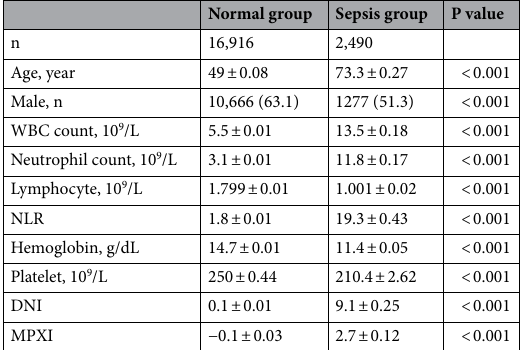
Table 1. General characteristics of study population based on sepsis status. Continuous and categorical variables are described as mean ± standard error and frequency (percent), respectively. Abbreviations: WBC, white blood cell; NLR, neutrophil–lymphocyte ratio; DNI, delta neutrophil index; MPXI, Myeloperoxidase Index; n,